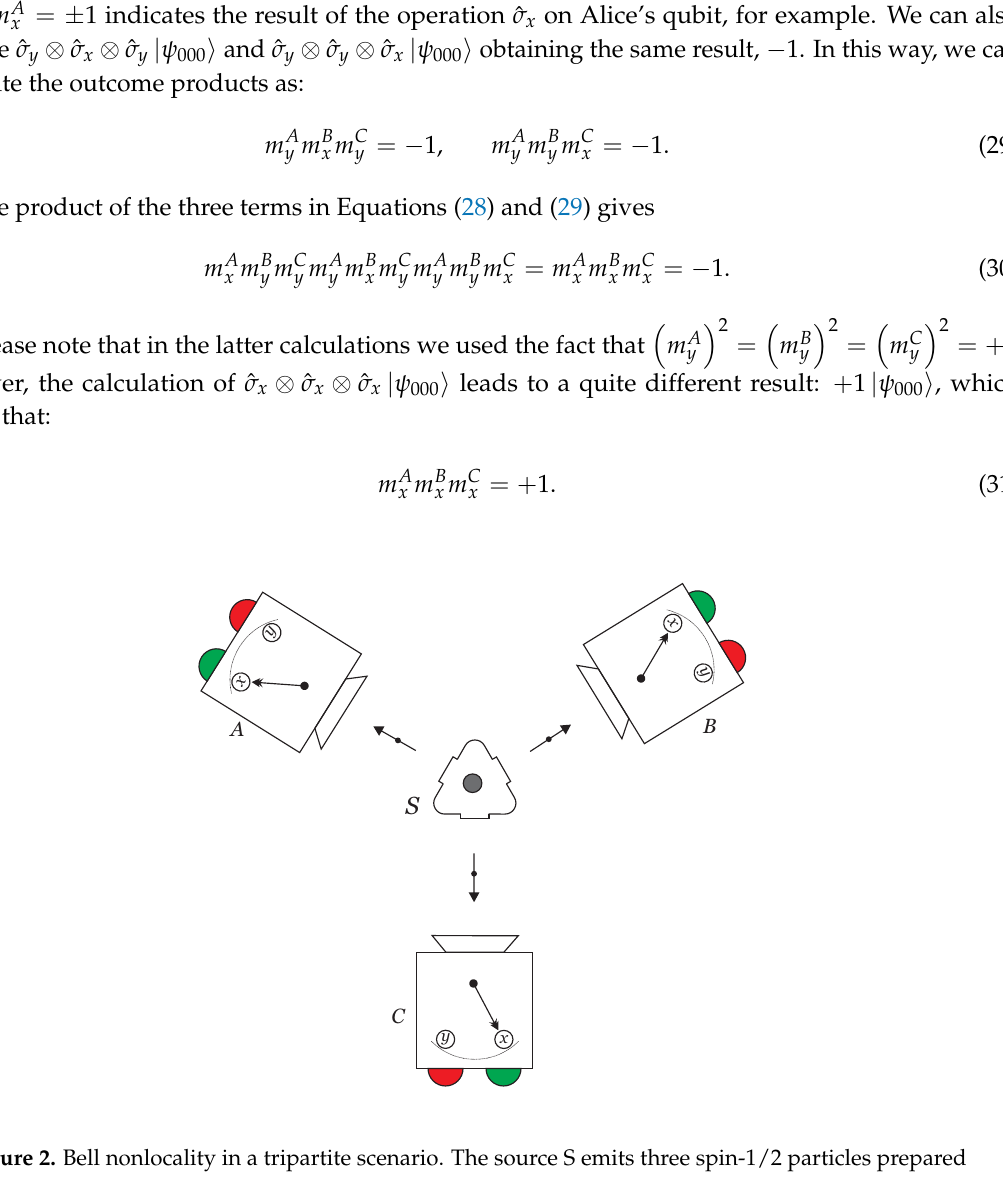
Figure 2. Bell nonlocality in a tripartite scenario. The source S emits three spin-1/2 particles prepared in a GHZ state, traveling to one out of three different detectors located in A, B and C. Each part, namely Alice, Bob and Charlie possess a Stern-Gerlach magnet, and can choose to perform either a ˆ σ x or a ˆ σ y measurement, obtaining the eigenvalues + 1 or − 1, corresponding to turn either green or red lights